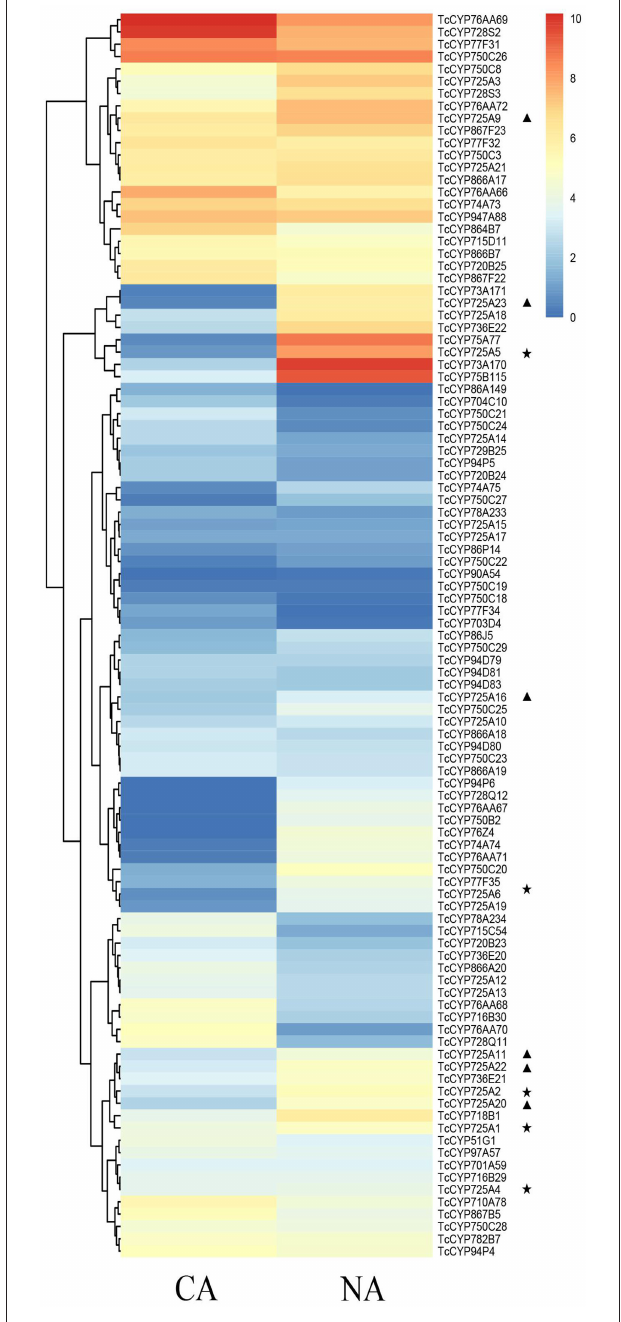
FIGURE 3 | Expression pattern of T. chinensis CYP450s in CA and NA cell lines according to the analysis of RNA-Seq dataset. The color scale shows the expression quantity (red: high expression; blue: low expression). Heat map was created using HemI. Heatmap Illustrator v1.0. “ ⋆ ” indicates the known taxoid hydroxylase genes, and “ N ” indicates the candidate genes.